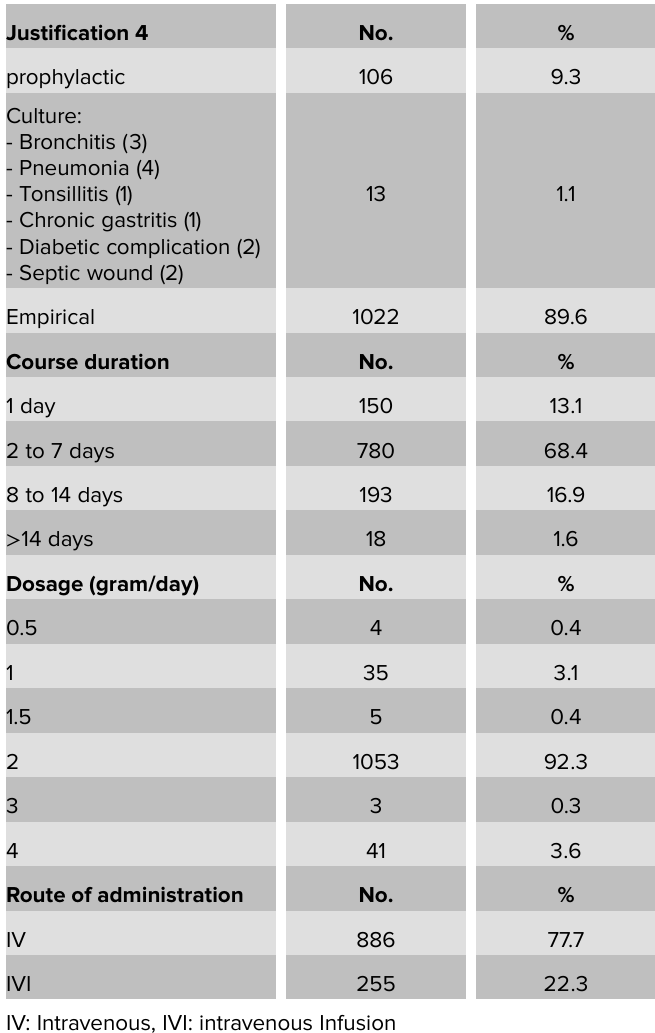
Table 2: Justification of ceftriaxone use (total of